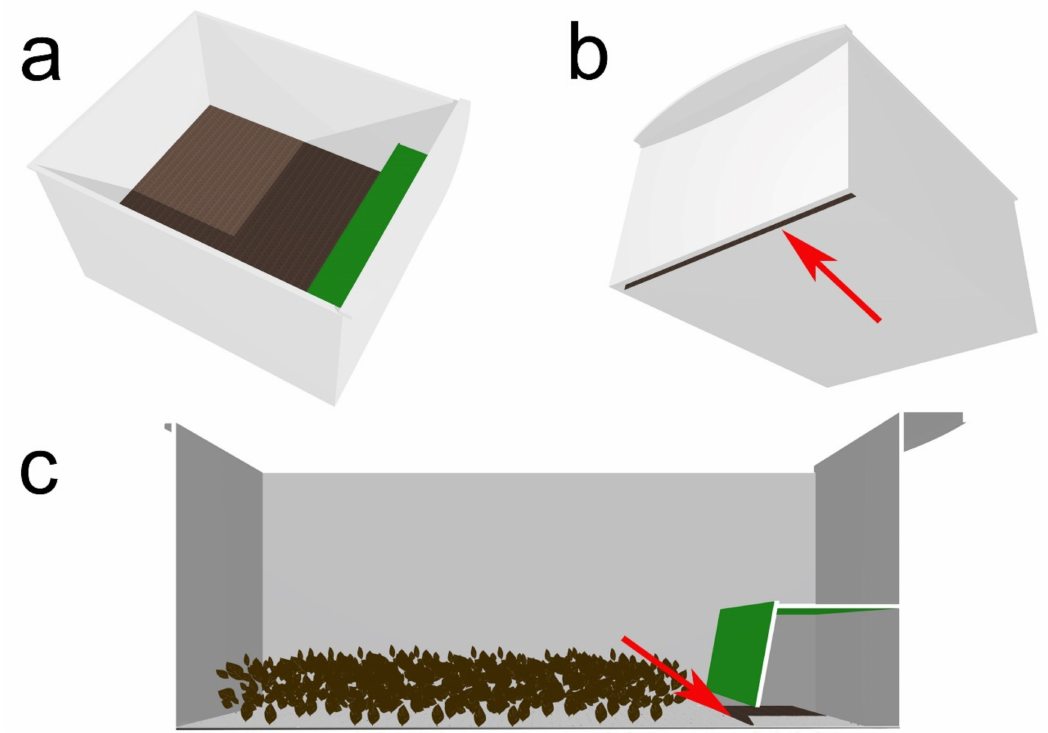
Figure 2. Experimental apparatus to separate prepupae from younger instars. ( a ) View from above. ( b ) View of the underside, the red arrow show the passage for larve ( c ) lateral section view, as shown above the red arrow indicates the 1 cm-wide passage at the base of the barrier through which the larvae can reach the collecting